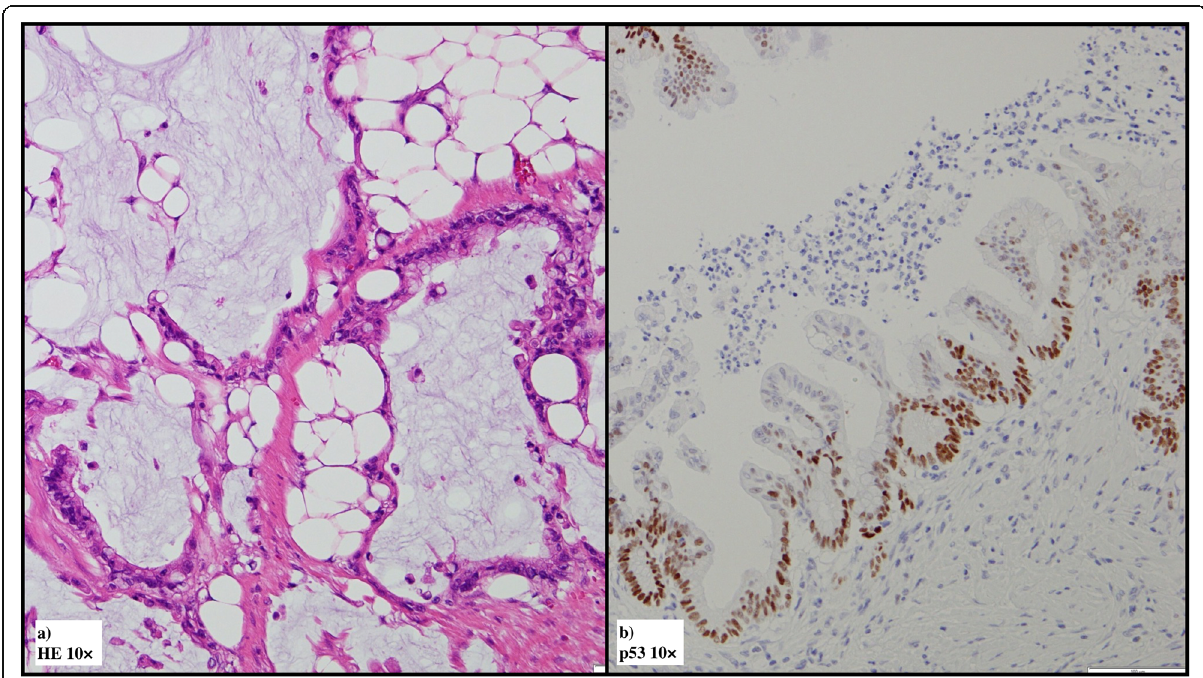
Fig. 5 Microscopic findings of the deep area of main tumor ( a HE ×20, b HE ×10, c p53 ×10, d HE ×20). a In deeper area, tumor cells secrete large amount of mucin (mucinous adenocarcinoma). b p53 was positive in 50% of tumor cells in mucinous